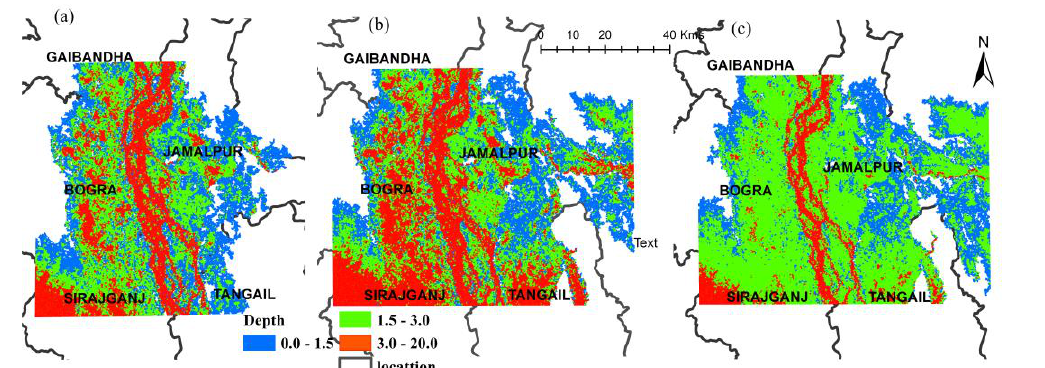
Fig. 6. Flood hazard mapping based on depth, (a) for 2 yrs return period, (b) for 25 yrs return period, (c) for 50 yrs return period.